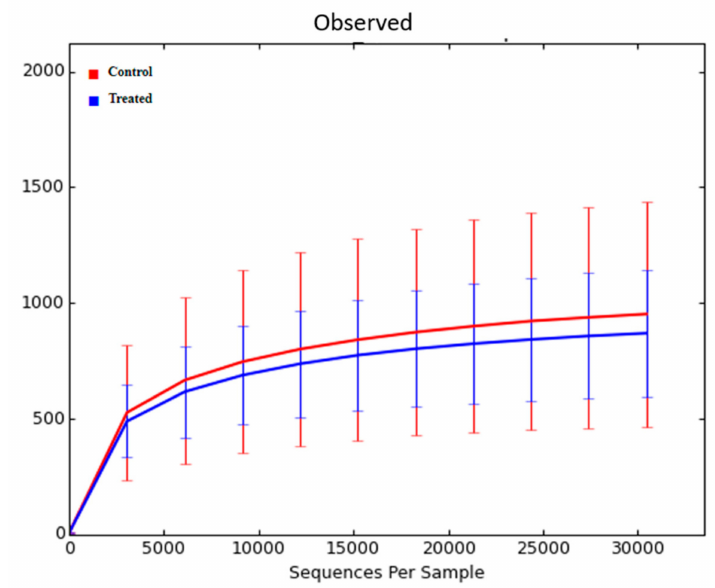
Figure 4. Rarefaction analysis of 16S rRNA amplicon sequence variants (observed ASV’s) obtained from nasal swabs of calves at weaning. Data from 11 calves from control cows and cows supplemented with Se-yeast boluses (105 mg Se/wk), during the first (TR-1) trimester of gestation, that had WB-Se in the range of 0.06 to 0.13 ng/mL were compared with 10 calves from cows supplemented with Se yeast during the second (TR-2) and third (TR-3) trimesters of gestation that had WB-Se in the range of 0.15 to 0.21 ng/mL. Table 2. Measures of alpha diversity (mean ± SD) in nasal microbiome genome from nasal swabs of calves at weaning. Data from 11 calves from control cows and cows supplemented with Se-yeast boluses (105 mg Se/wk), during the first (TR-1) trimester of gestation, that had WB-Se in the range of 0.06 to 0.13 ng/mL were compared with 10 calves from cows supplemented with Se yeast during the second (TR-2) and third (TR-3) trimesters of gestation that had WB-Se in the range of 0.15 to 0.21 ng/mL. Calves from Control Calves from TR-2 p -Value and TR-1 Dams and TR-3 Dams ( n = 11) ( n = 10) Chao1 1028 ± 564.4 Observed